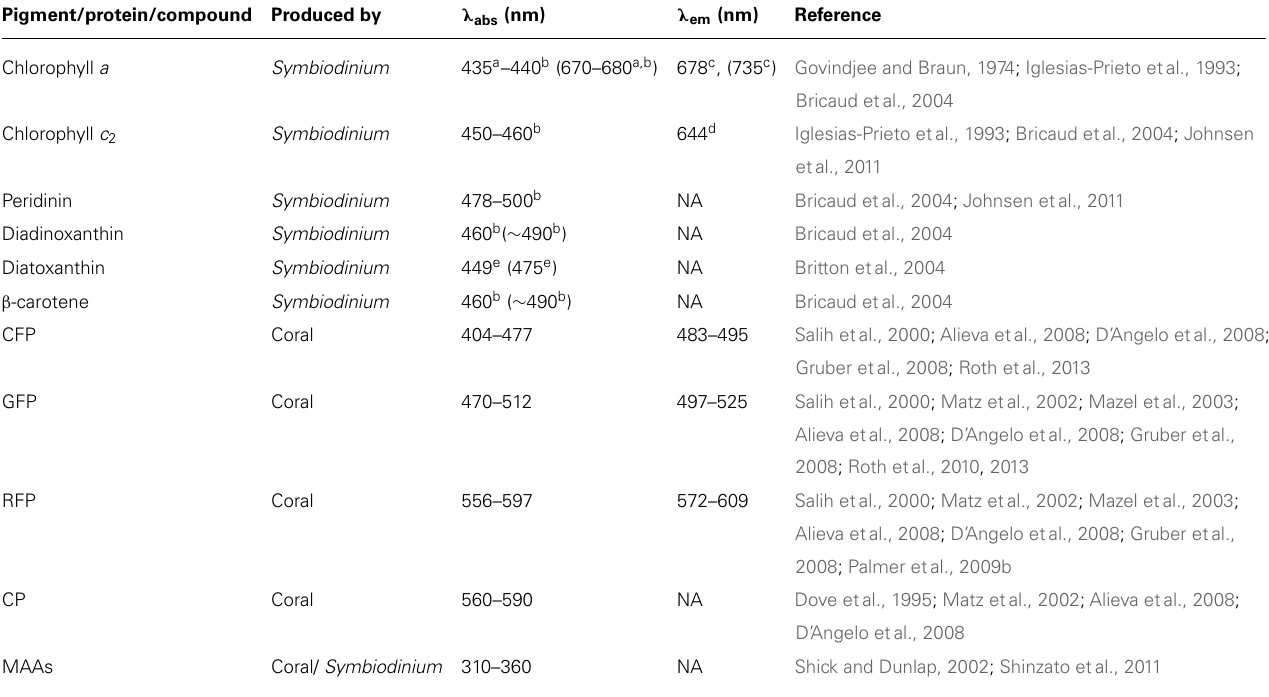
Table 2 | Summary of light absorbing and emitting pigments, proteins, and compounds in the coral–algal symbiosis. Pigment/protein/compound Produced